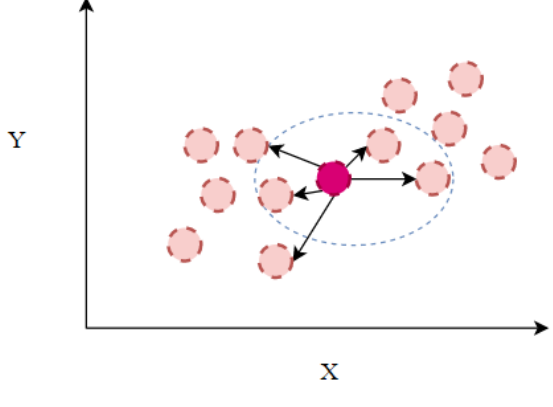
Figure 2. KNN algorithm structure.